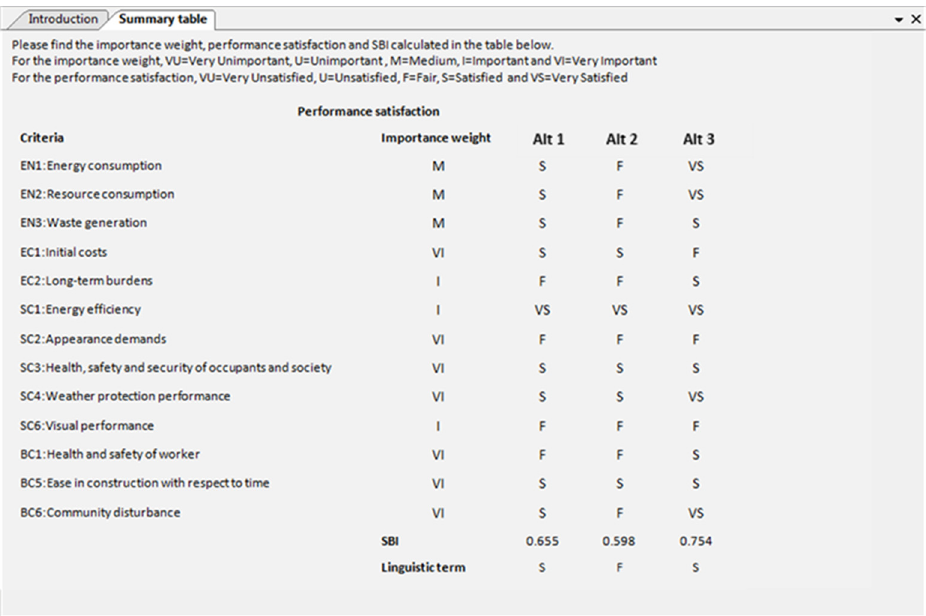
Figure 6. Assessment of the performance satisfaction of the design alternatives.